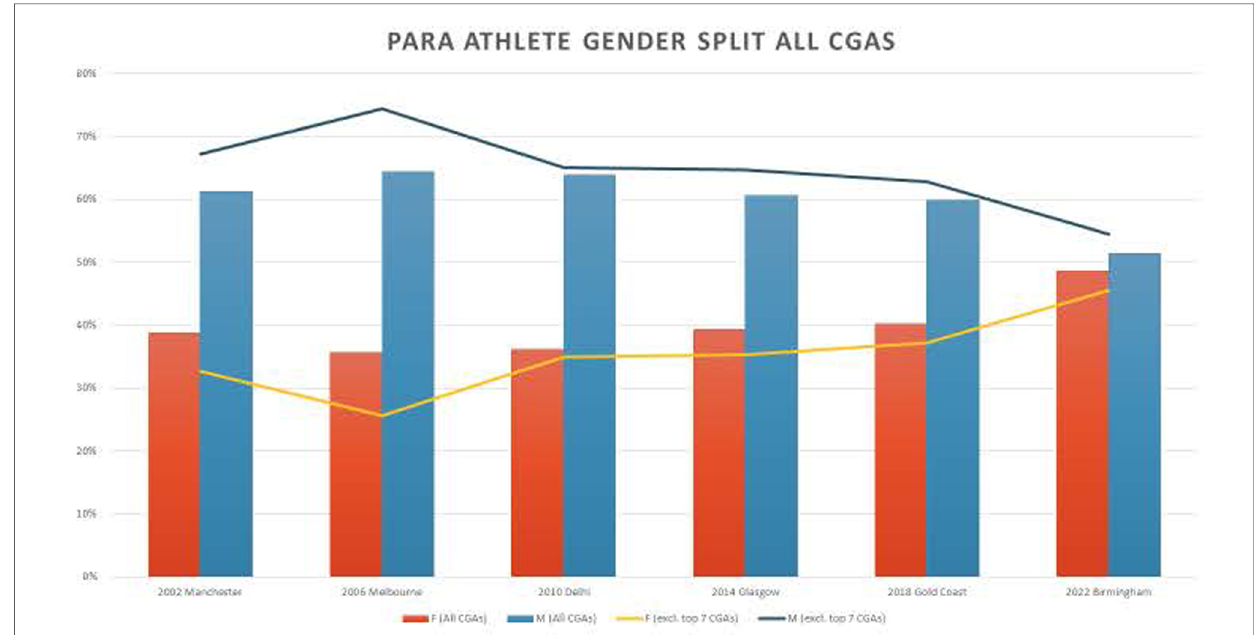
FIGURE 2 Para athlete gender parity at CG 2002-2022. Figure 2 was prepared by CGF post B2022. Pam sport analysis: for the purposes of understanding the impact of GAPS on Birmingham